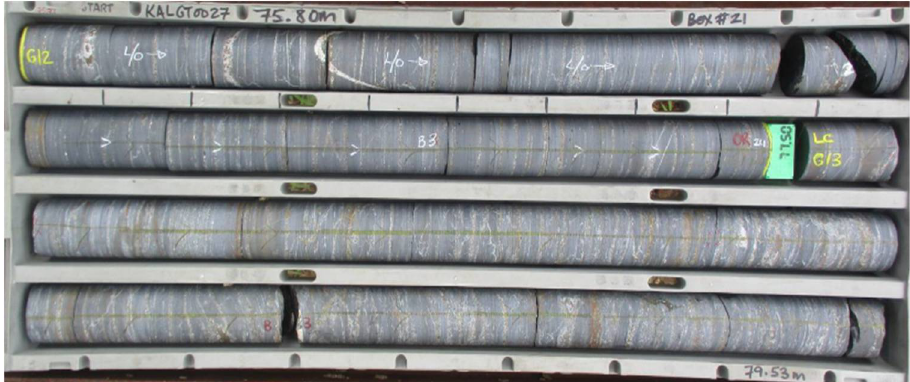
Figure 3. Core logs from borehole drilling during site investigation (Adapted from [5]).